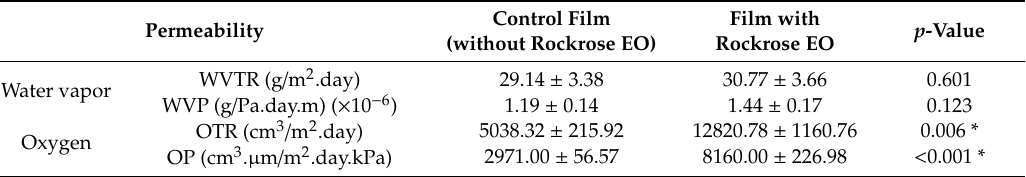
Table 7. Barrier properties of the